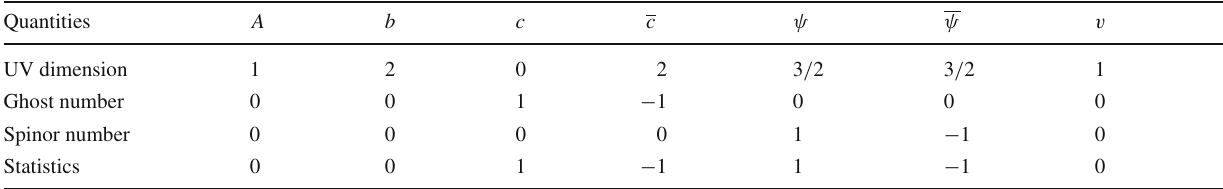
Table 1 Quantum numbers of the fields and background tensors Quantities UV